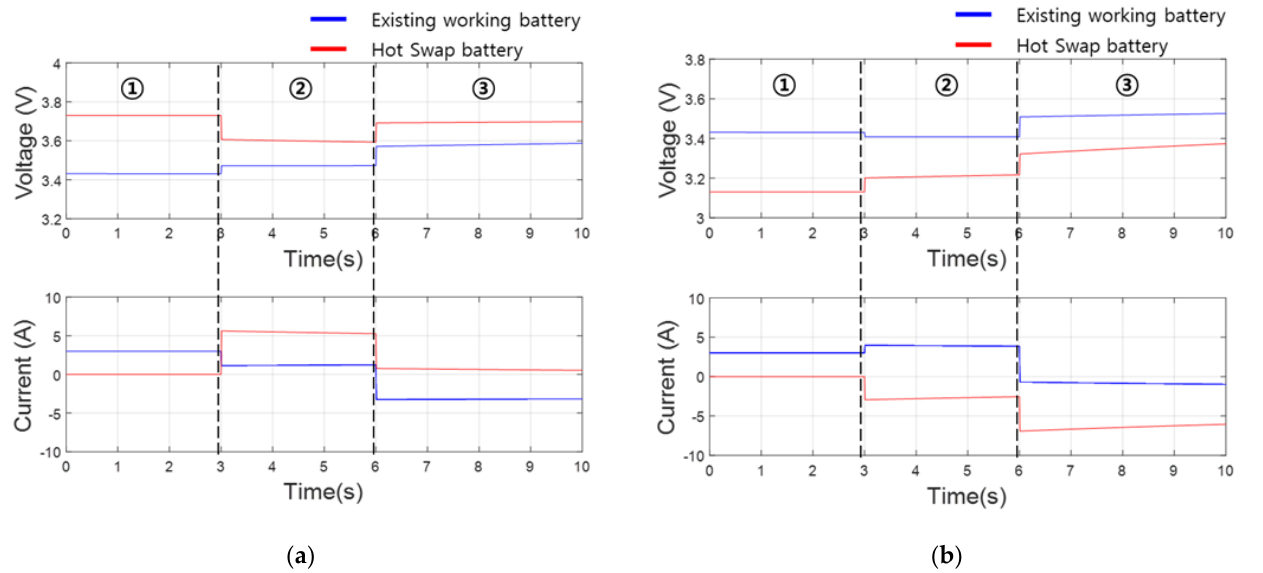
Figure 14. Simulation results of the hot-swap operation when inserting a battery with ± 0.3 V difference: ( a ) +0.3V battery hot swap; ( b ) − 0.3 V battery hot swap.